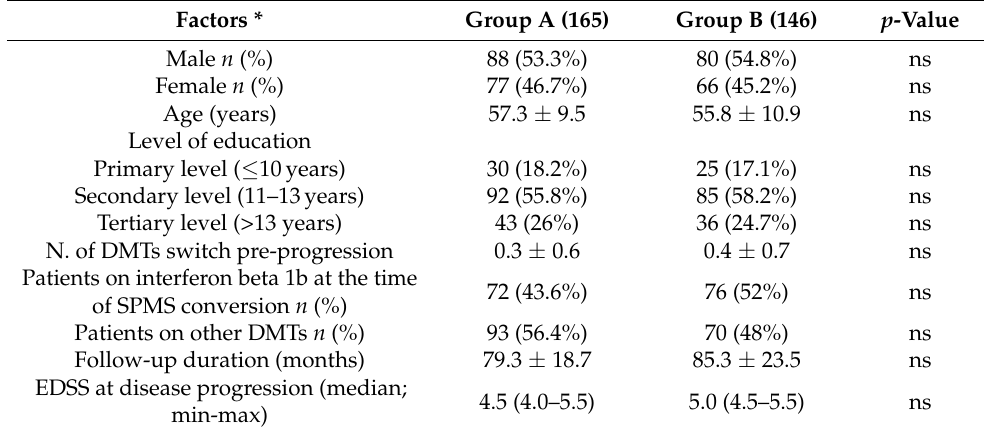
Table 1. Demographical and clinical characteristic of the two groups.